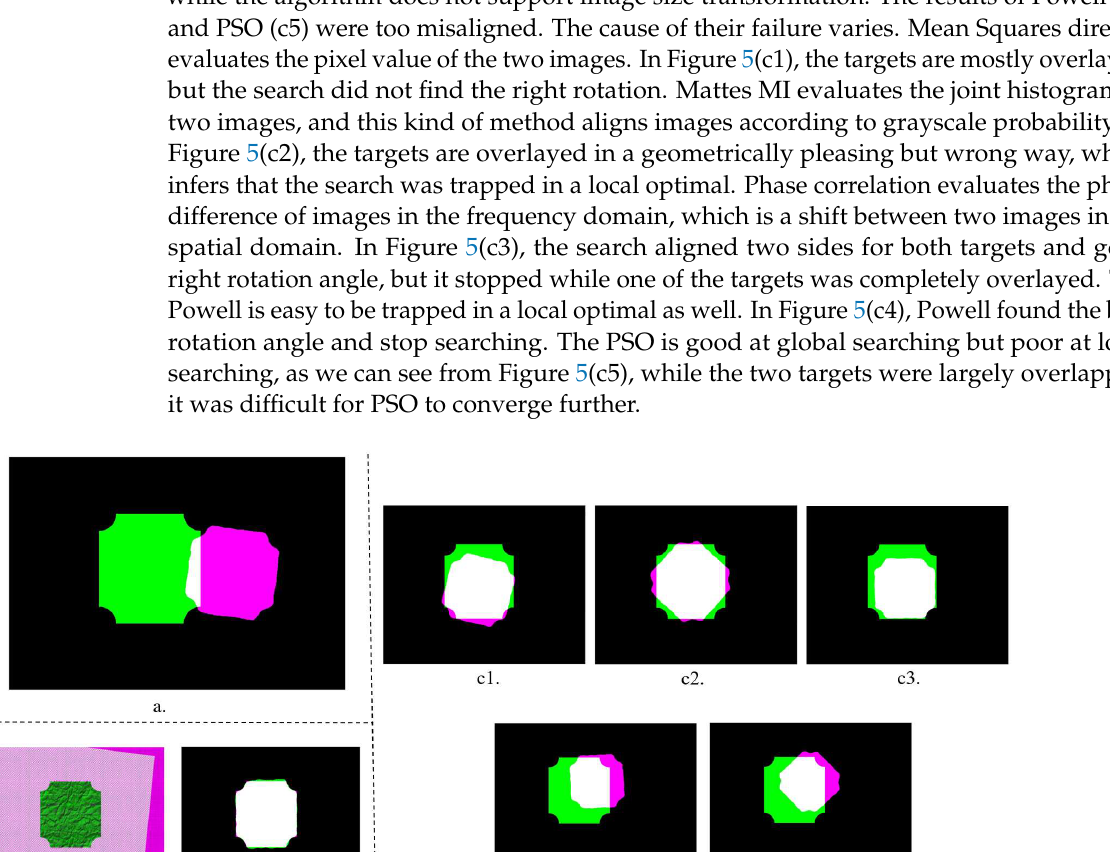
Figure 6. SSR application in real world imaging. The registration accuracy rate of SSR reached 91.02% in the original image pair ex- periment. In contrast, SURF, MSER Brisk, FAST, Harris, and MinEigen did not work out